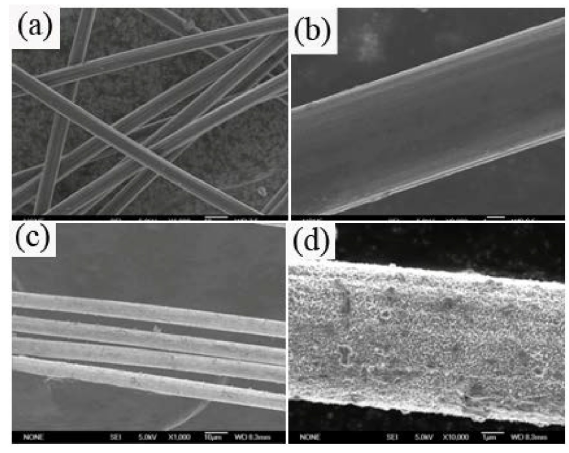
Figure 4: FESEM of the carbon fibers before (a-b) and after(c-d) coated by